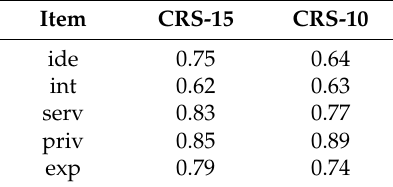
Table 7. R 2 of the first level latent variables of the CRS in the confirmatory factor